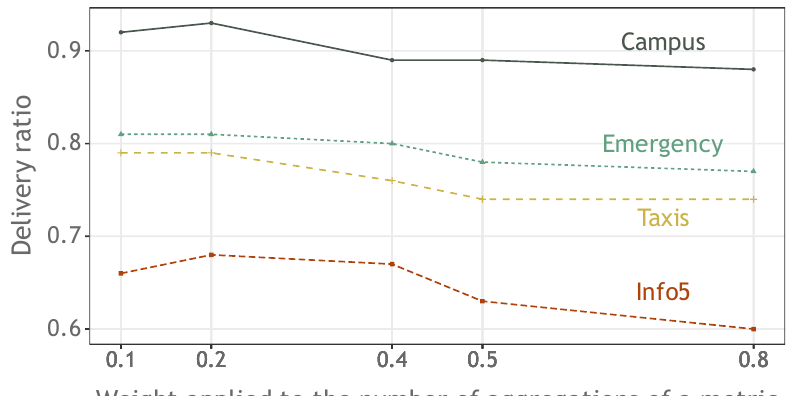
Figure 19. Delivery ratio for different α weights.